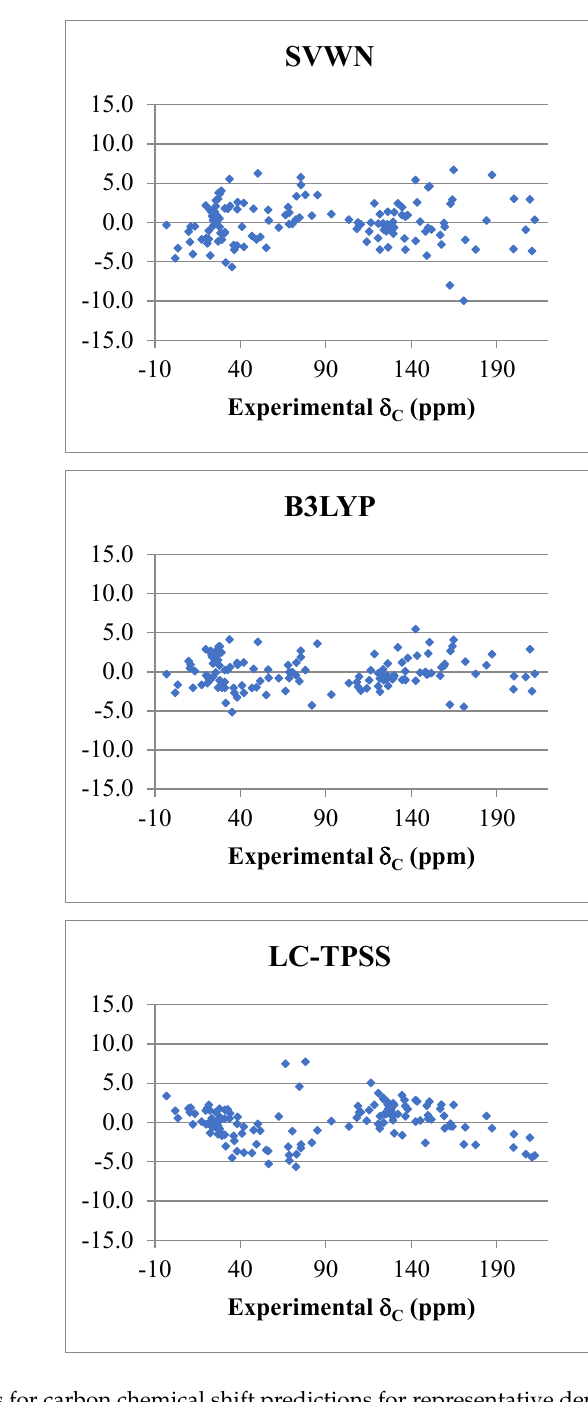
Figure 5. Comparison of deviations for carbon chemical shift predictions for representative density functionals and HF (cc-pVTZ basis sets, B3LYP/6-31G* optimized geometries, and PCM solvation model for chloroform was used in all instances).